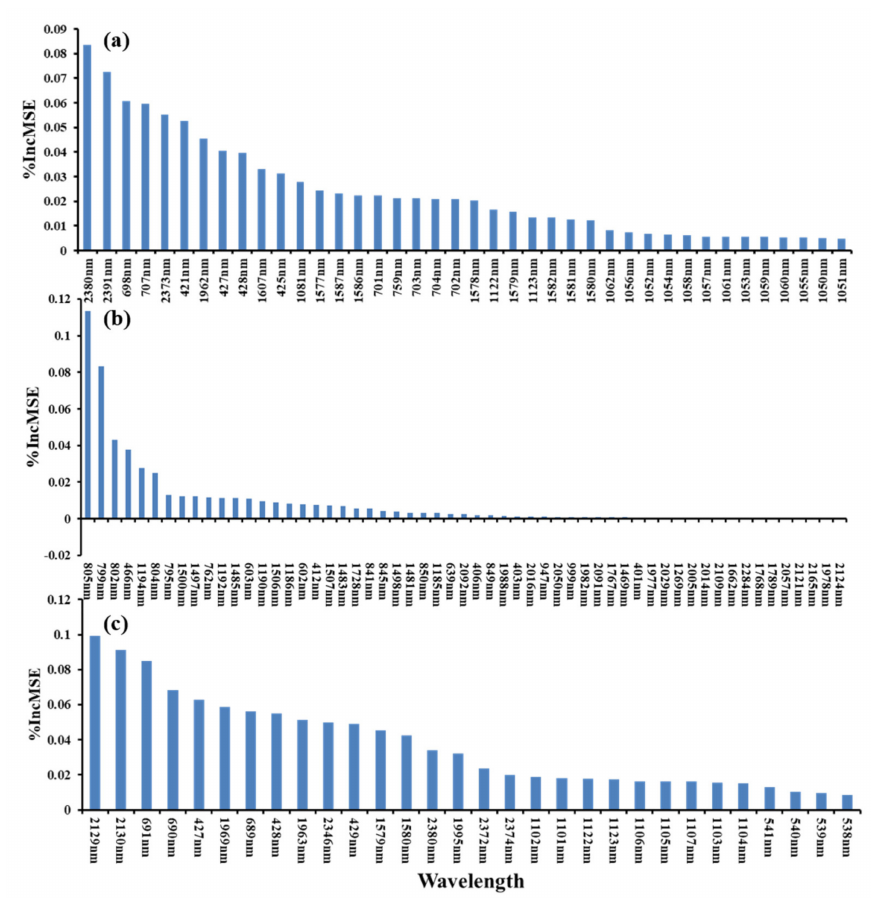
Figure 10. Relative variable importance analysis based on important bands (Table 4) for reflectance spectra ( a ), first derivative spectra ( b ), and reciprocal logarithm-transformed spectra ( c ). We used the importance function in the “RandomForest” package to perform this analysis. The %IncMSE represents the percent increase in mean squared